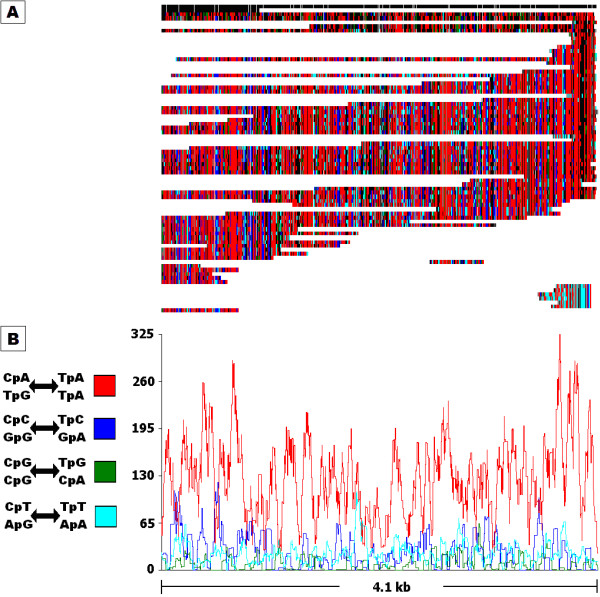
RIPCAL analysis of the X0 repeat family of Stagonospora nodorum, representative of a repeat family exhibiting strongly dominant classical CpA→TpA type RIP mutation. A) multiple alignment of the putative transposon repeat family X0 compared to highest G:C content model. Incomplete repeated regions are typical for repeat family alignments illustrated by the blocks in white in panel A. Black = match; grey = mismatch; white = gap. Mismatches corresponding to selected di-nucleotide changes are coloured as indicated. B) Overall RIP mutation frequency graph over a 50 bp scanning window, corresponding to the alignment above, demonstrating the overall dominance of the CpA↔TpA mutation over other CpN↔TpN mutations for the X0 repeat family.